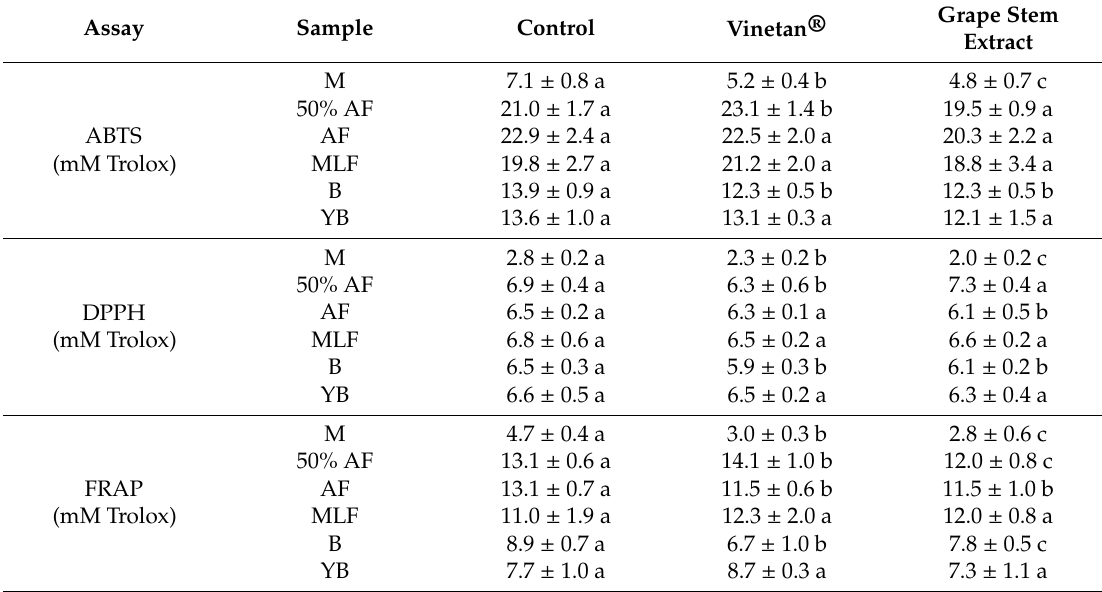
Table 3. Antioxidant capacity measured by ABTS, DPPH and FRAP assays of must (M), wine at 50% alcoholic fermentation (50% AF), end of alcoholic fermentation (AF), end of malolactic fermentation (MLF), bottling (B), and one year after bottling (YB) in control samples, samples with Vinetan ® and wines with grape stem extract (Mean ± SD, n =